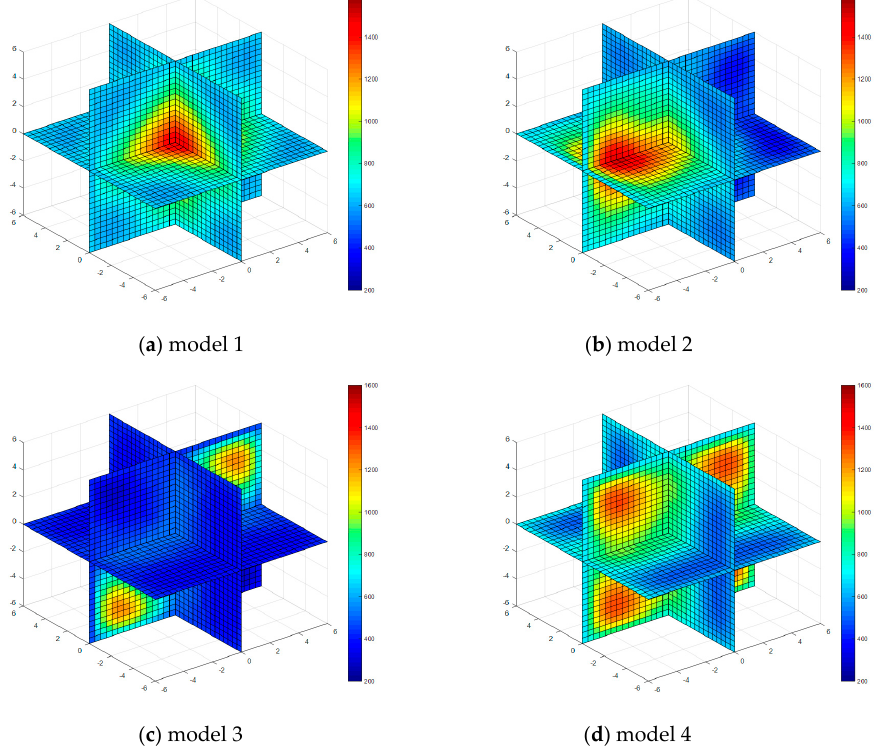
Figure 6. Diagram of reconstructed temperature fields by standard Tikhonov regularization method.